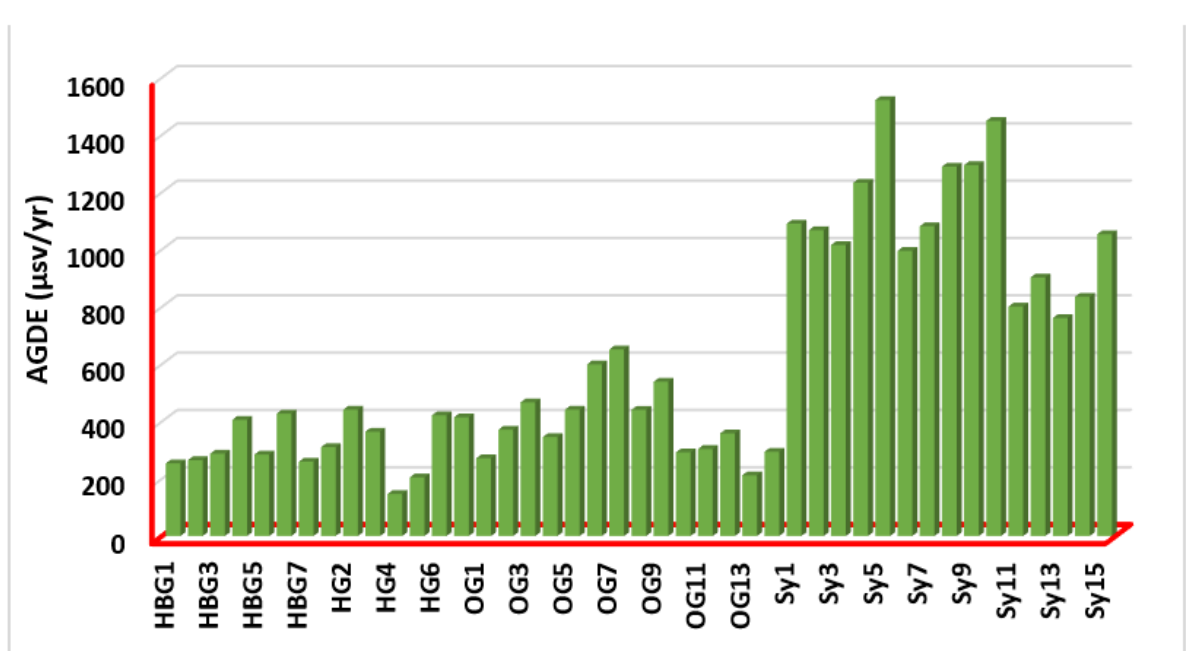
Figure 7. Indoor annual effective doses (AED outdoor ) for all (7 hornblende biotite gneisses; 7 biotite gneisses; 14 older granites; and 15 syenogranites) rock samples.